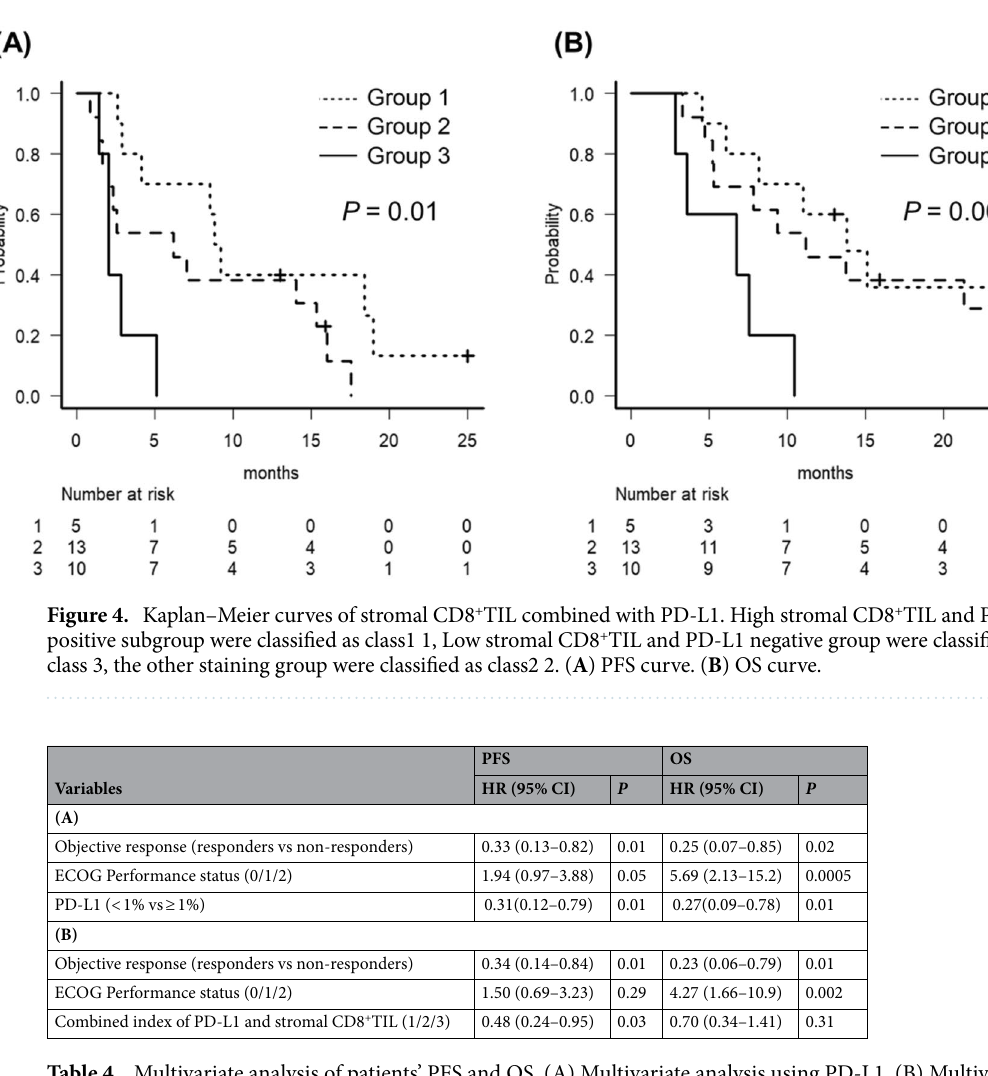
Table 4. Multivariate analysis of patients’ PFS and OS. (A) Multivariate analysis using PD-L1. (B) Multivariate analysis using combined index of PD-L1 and stromal CD8 + TIL.